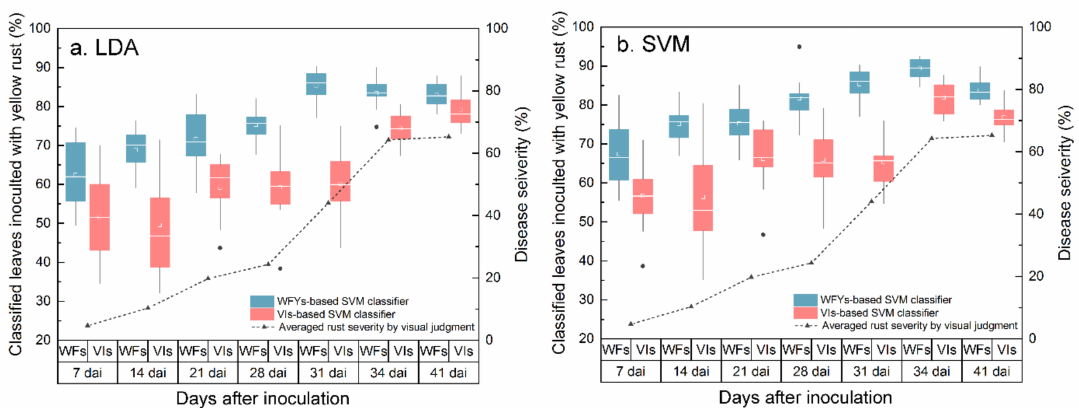
Figure 7. Effect of time since inoculation on the classification accuracy results of ASD spectroradiometer-derived ( a ) linear discriminant analysis (LDA) and ( b ) support vector machine (SVM) model for the identification of diseased leaves inoculated with yellow rust versus healthy leaves. The box-plot of the classification accuracies are produced by the cross-validation. The dash line represents the averaged rust severity (DR) measured per sampling date.